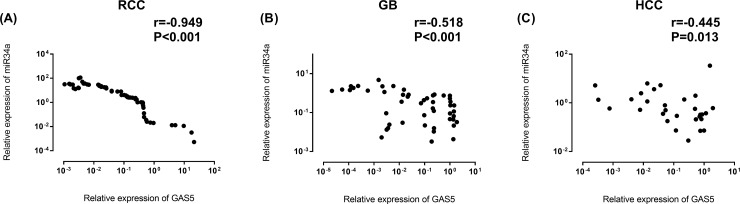
Correlation between GAS5 and miR-34a-5p expression levels.RCC renal cell carcinoma, GB glioblastoma, HCC hepatocellular carcinoma. Data were log transformed. Spearman’s rank correlation test was used. Statistical significance was considered at p < 0.05.